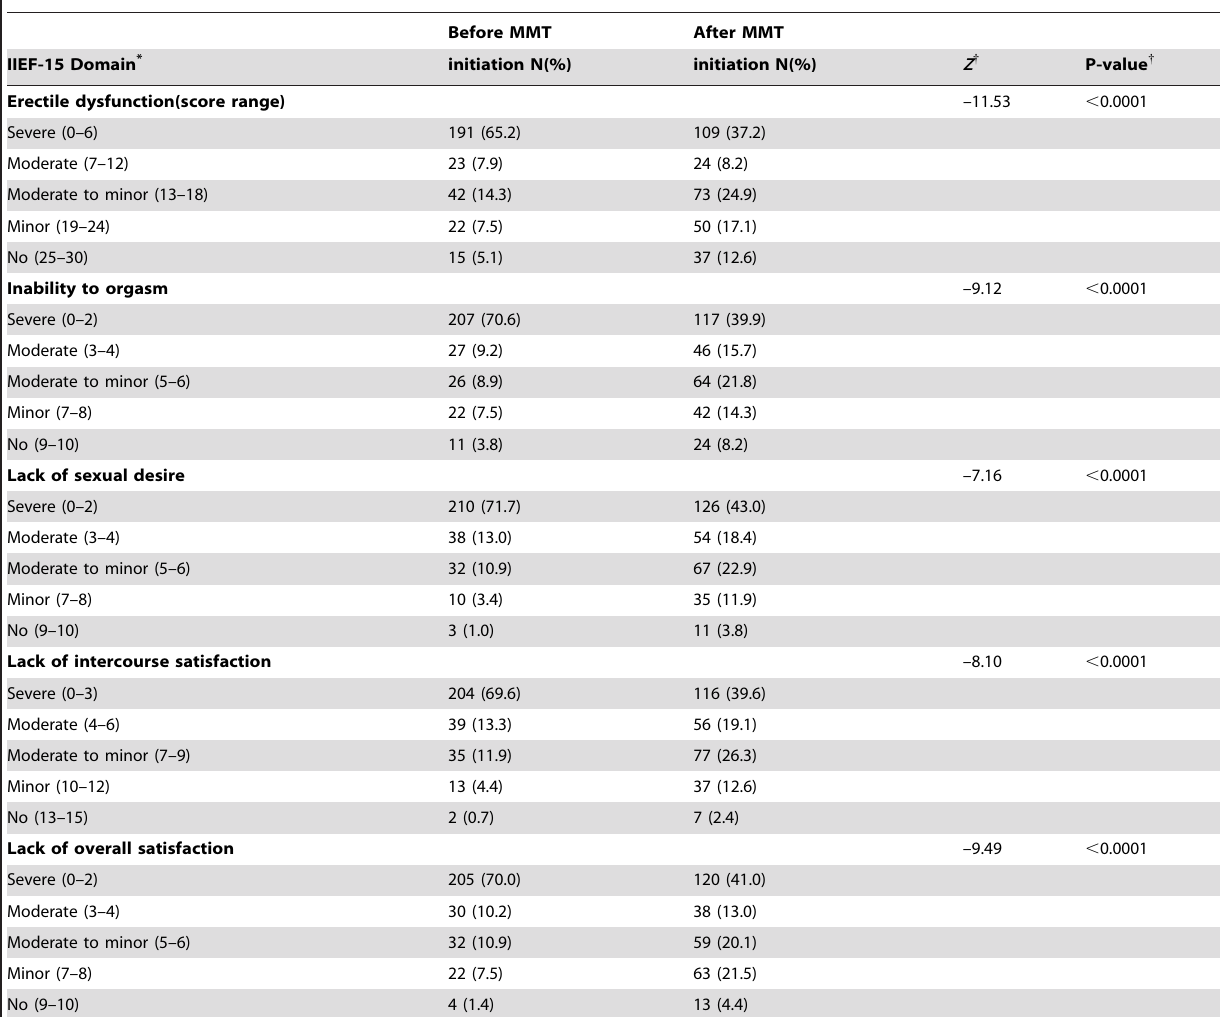
Table 3. Self-reported sexual dysfunction before and after MMT